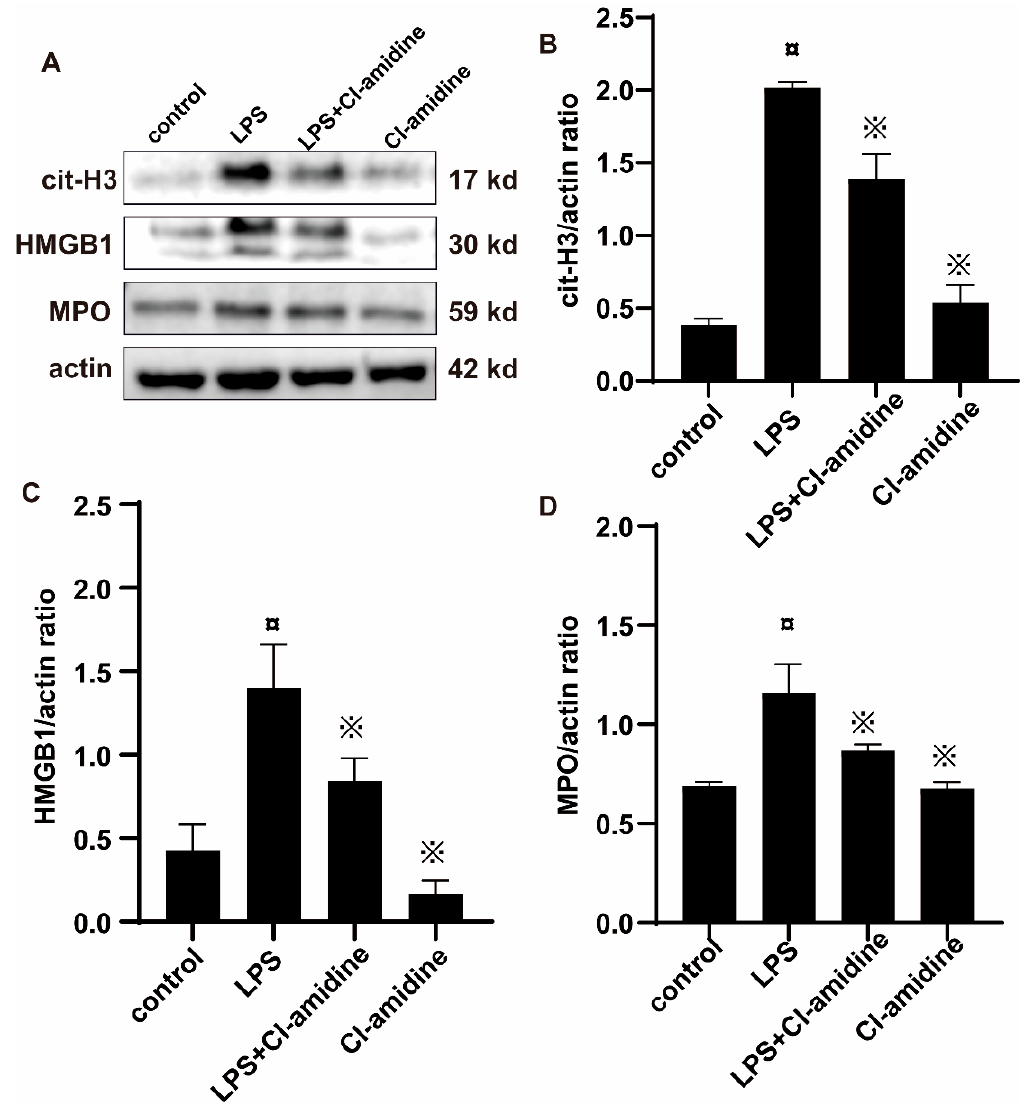
Figure 6. Effect of Cl-amidine on NETs-derived proteins in LPS-induced rat uterine tissues. The rats were grouped into four groups of five animals each. The control group was given normal saline, and groups 2, 3, and 4 were treated with LPS, Cl-amidine and LPS, and Cl-amidine, respectively. After the treatment, protein was extracted from the uterine tissues, and the protein expression was determined using the Western blot technique. ( A ) shows the expression blot of NETs-derived proteins were expressed, including cit-H3, HMGB1, and MPO with different molecular weight. ( B ) The graphs show the expression of cit-H3 in the different treatment groups. ( C ) The graphs show the expression of HMGB1 in the different treatment groups. ( D )The graphs show the expression of MPO in the different treatment groups. Gray values of figure were analyzed by Image J. The values given are mean ± SD ( n = 5 animals per group). ¤ p < 0.05 vs. control rats and ※ p < 0.05 vs. LPS without Cl-amidine.